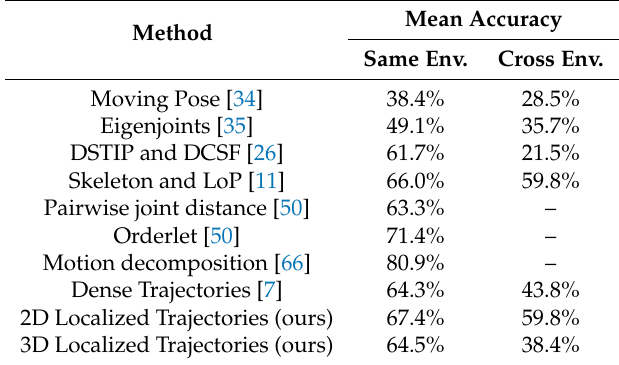
Table 3. Mean accuracy of recognition (%) on ORGBD dataset for Dense Trajectories and 2D Localized Trajectories approaches against literature in both Same and Cross Environment Settings.